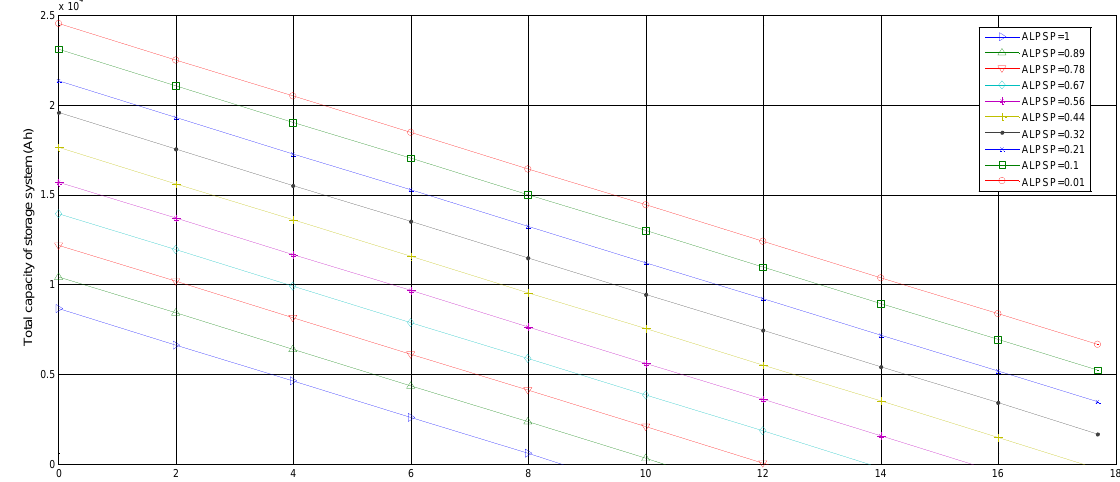
Figure 9 . Different PV/battery combinations versus different values of average loss of power supply probability